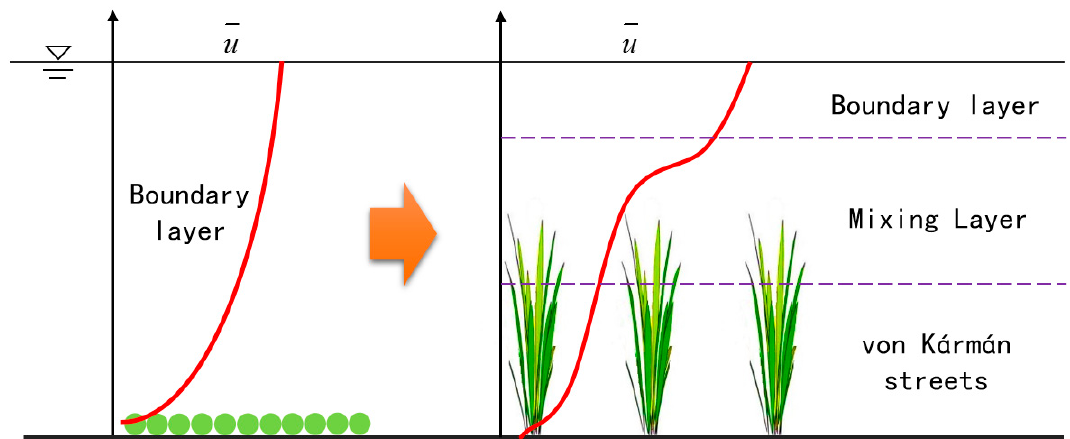
Figure 1. Sketch of the roughness effect and canonical mean velocity profile shape for a small-scale obstacle ( left ) and tall vegetation ( right ).